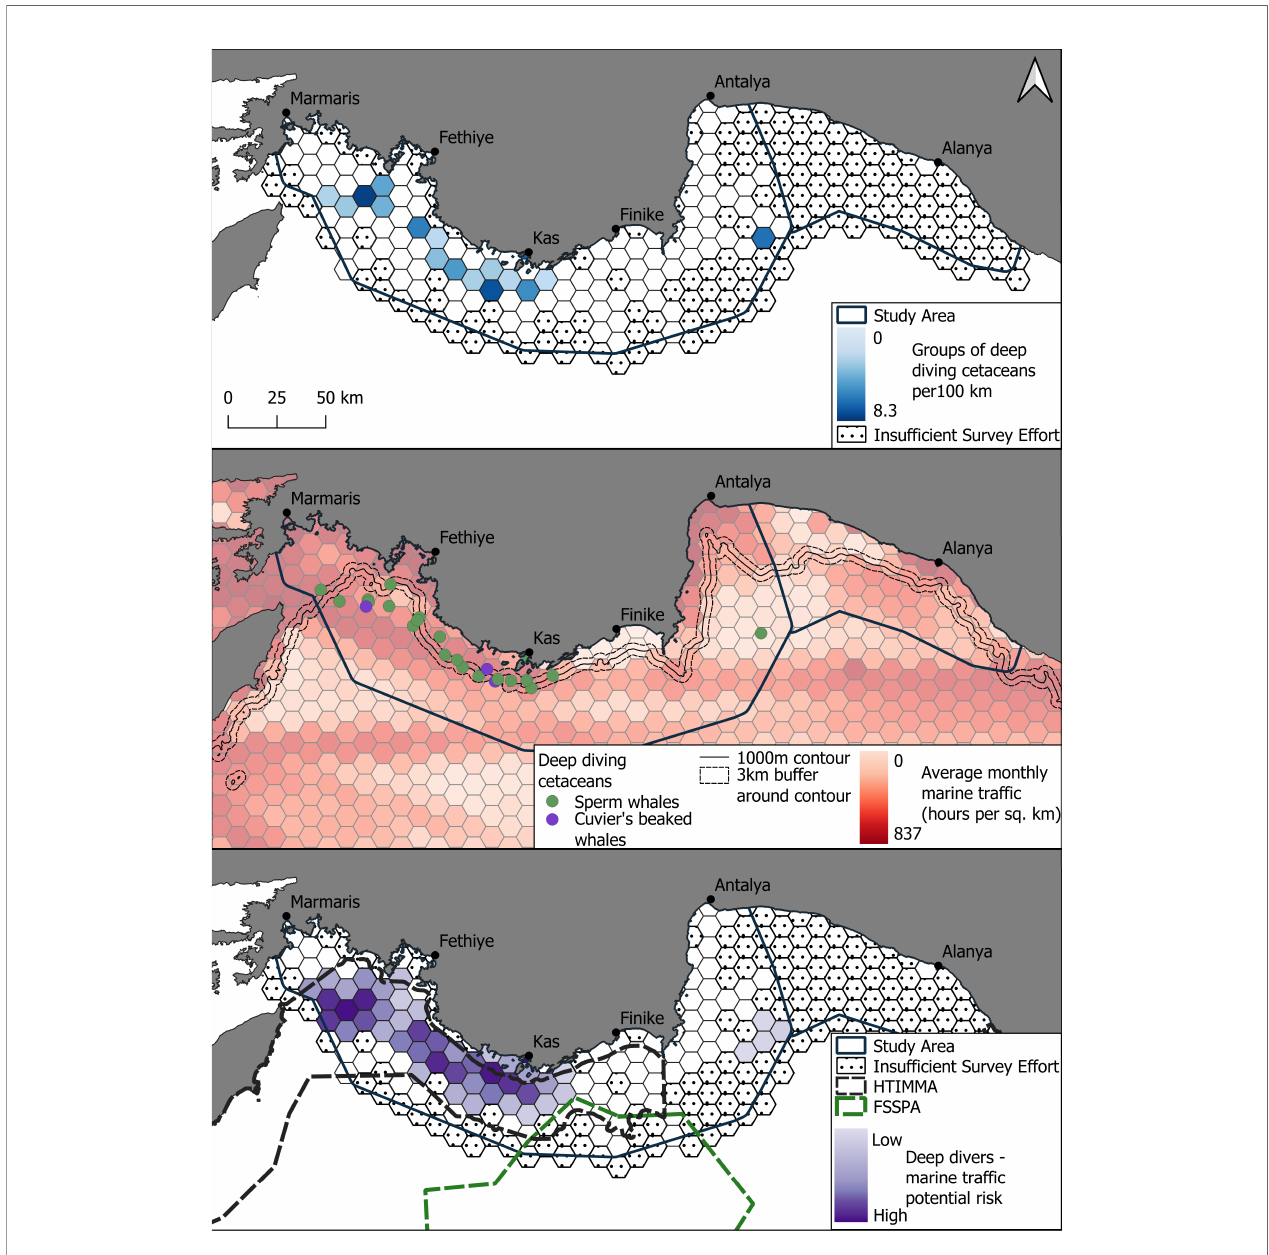
FIGURE 4 | (Upper) Groups of deep diving cetaceans per 100 km in the Eastern Mediterranean Sea with darkening blue representing an increased number of delphinid groups. (Middle) The distribution of different deep diving cetacean species with sperm whales and Cuvier's beaked whales denoted in green and purple circles respectively. Distribution is superimposed onto the average monthly marine traf fi c (hours per square kilometre) with darkening red signifying higher traf fi c. Marine vessel information used in this fi gure was made available by the EMODnet Human Activities project, www.emodnet-humanactivities.eu, funded by the European Commission Directorate General for Maritime Affairs and Fisheries. The 1000m contour is shown with a 3km buffer area around the contour. (Lower) Potential risk areas where the presence of deep diving cetacean and marine traf fi c were both high during the study period. Darkening purple shows an increased potential for